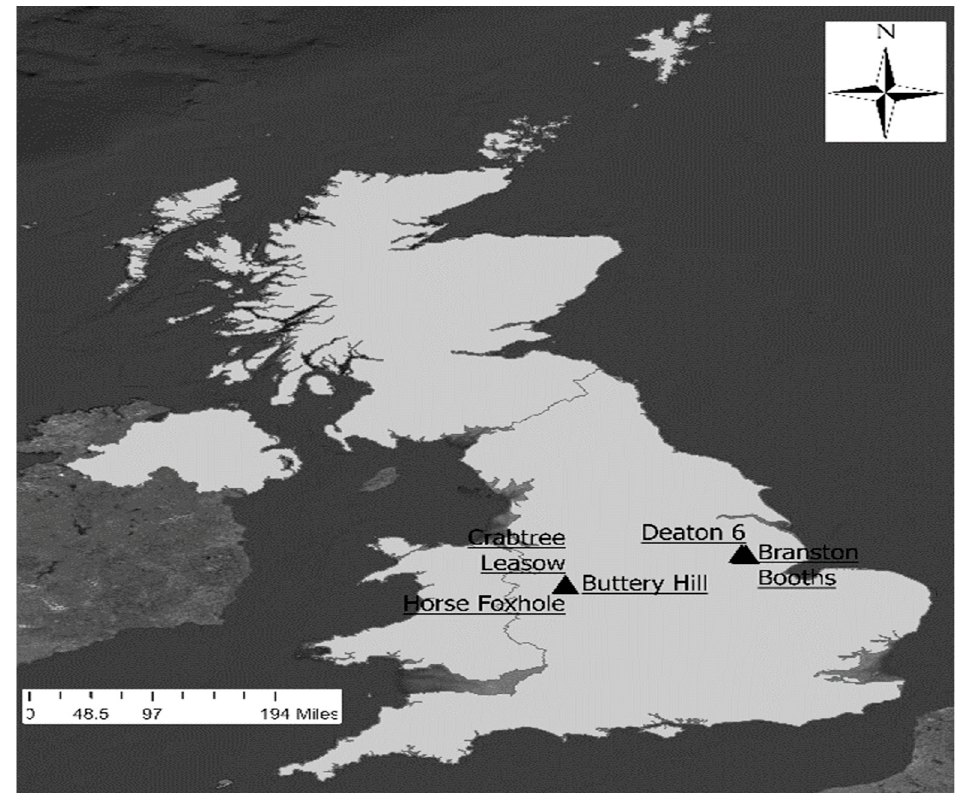
Figure 1. Map of the United Kingdom territory showing the locations of the 5 study sites (Crabtree Leasow, Horse Foxhole Buttery Hill, Deaton 6, and Branston Booths).